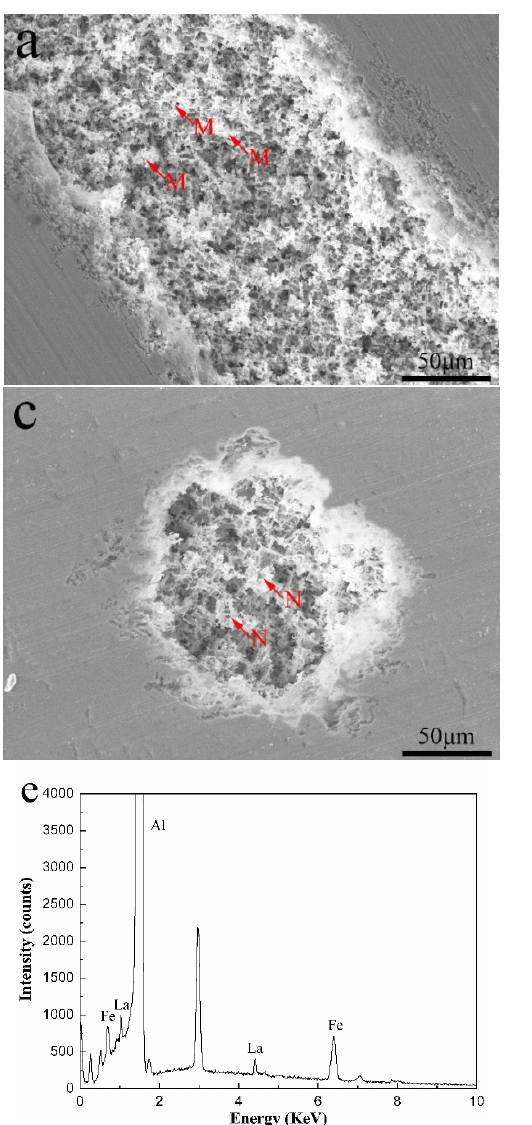
Figure 10. SEM images and energy dispersive X-ray spectroscopy (EDS) patterns of corrosion surface of the alloys: ( a ) Al-0.2Fe-0.06Cu; ( b ) Al-0.2Fe-0.06Cu-0.1La; ( c ) Al-0.2Fe-0.06Cu-0.15La; ( d , e ) EDS pattern of AlFe particle (M) and AlFeLa particle (N).